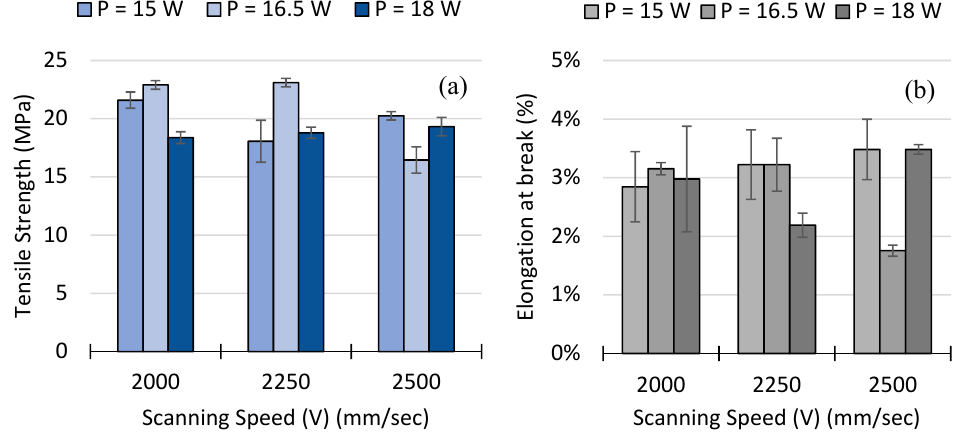
Figure 5. Variation of ( a ) the tensile strength and ( b ) elongation at break as a function of laser power ( P ) and scan speed ( V ).